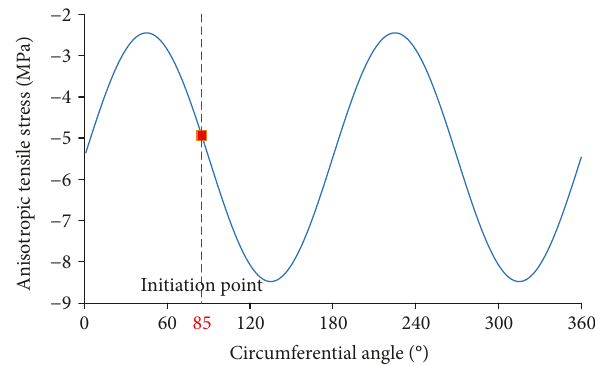
Figure 5: Transformation curve of the anisotropic tensile strength with the circumferential angle.